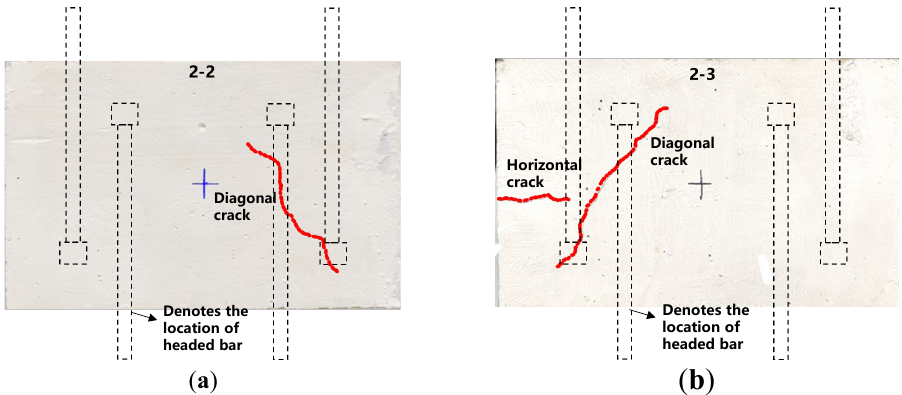
Figure 6. Crack development at peak load ( a ) Diagonal crack (specimen 2-2); ( b ) Horizontal crack (specimen 2-3).